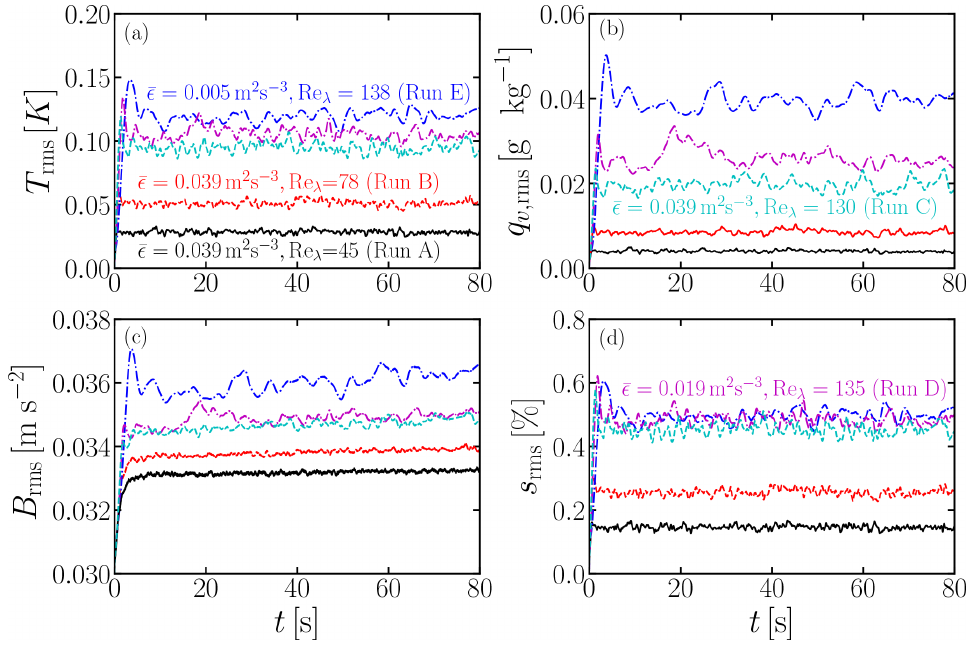
Figure 2. Time series of the field quantities: (a) T rms , (b) q v , rms, (c) B rms , and (d) s rms . Same simulations as in Fig. 1.